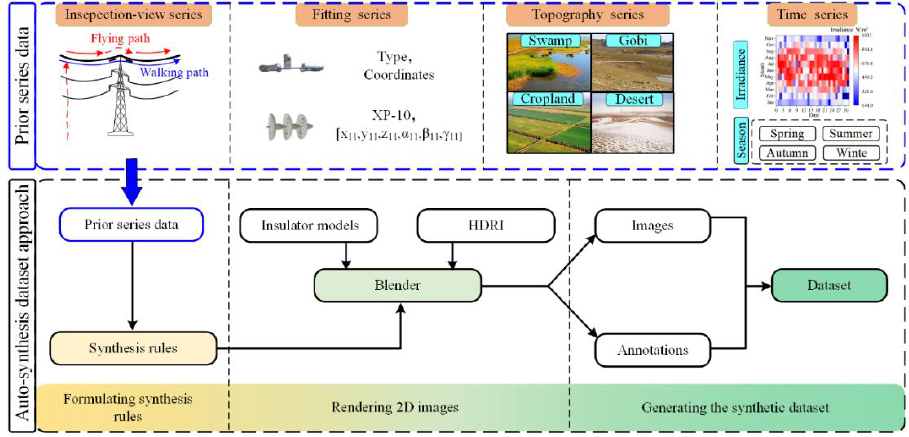
Figure 6. Diagram of the fitting recognition approach.